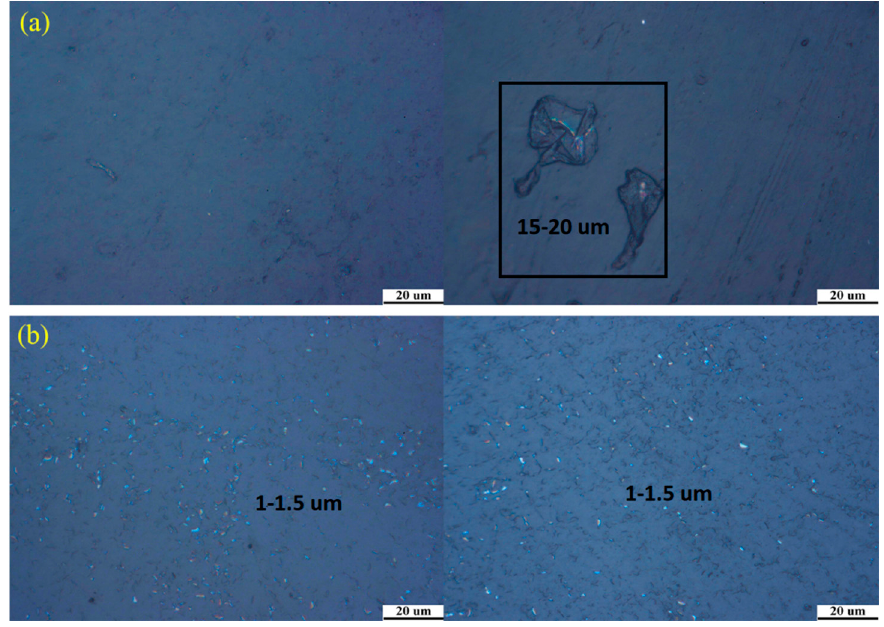
Figure 8. Inverted metallurgical microscope images of ( a ) 1%S monolayer and ( b ) 1%S double.